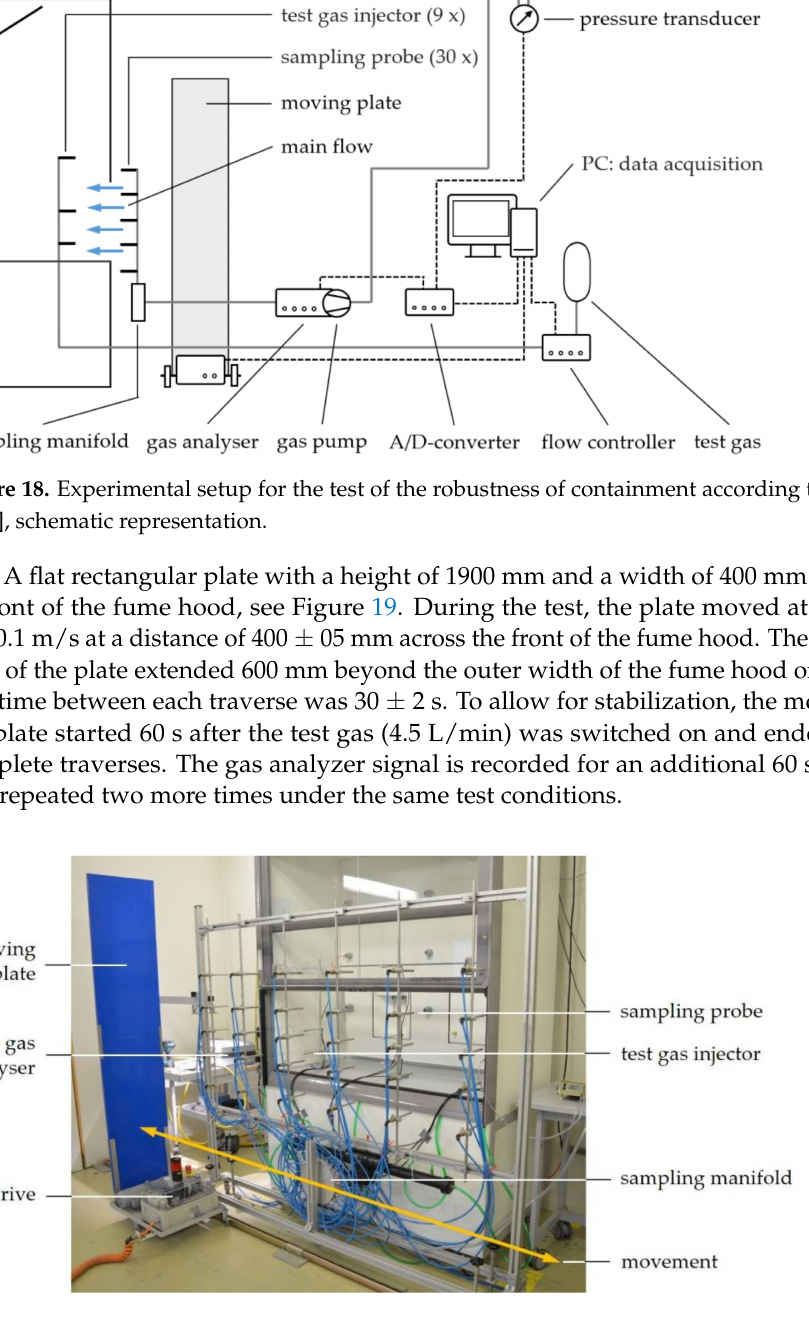
Figure 19. Moving plate for testing robustness of containment according to EN 14175-3